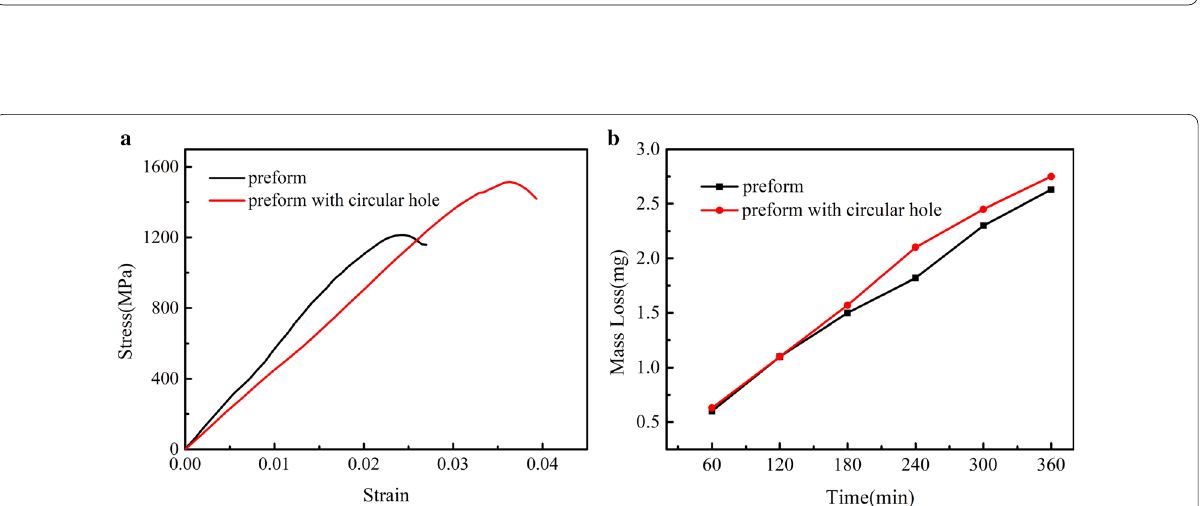
Fig.8 The position of the 2D transversal of the optimized model and stress transversal comparison. a Initial perform, b preform with circular holes added, c solidification stress, d compression stress